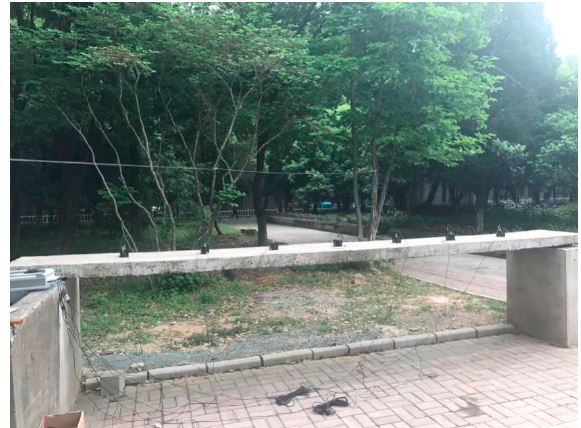
Figure 1. Reinforced concrete (RC) Slab.